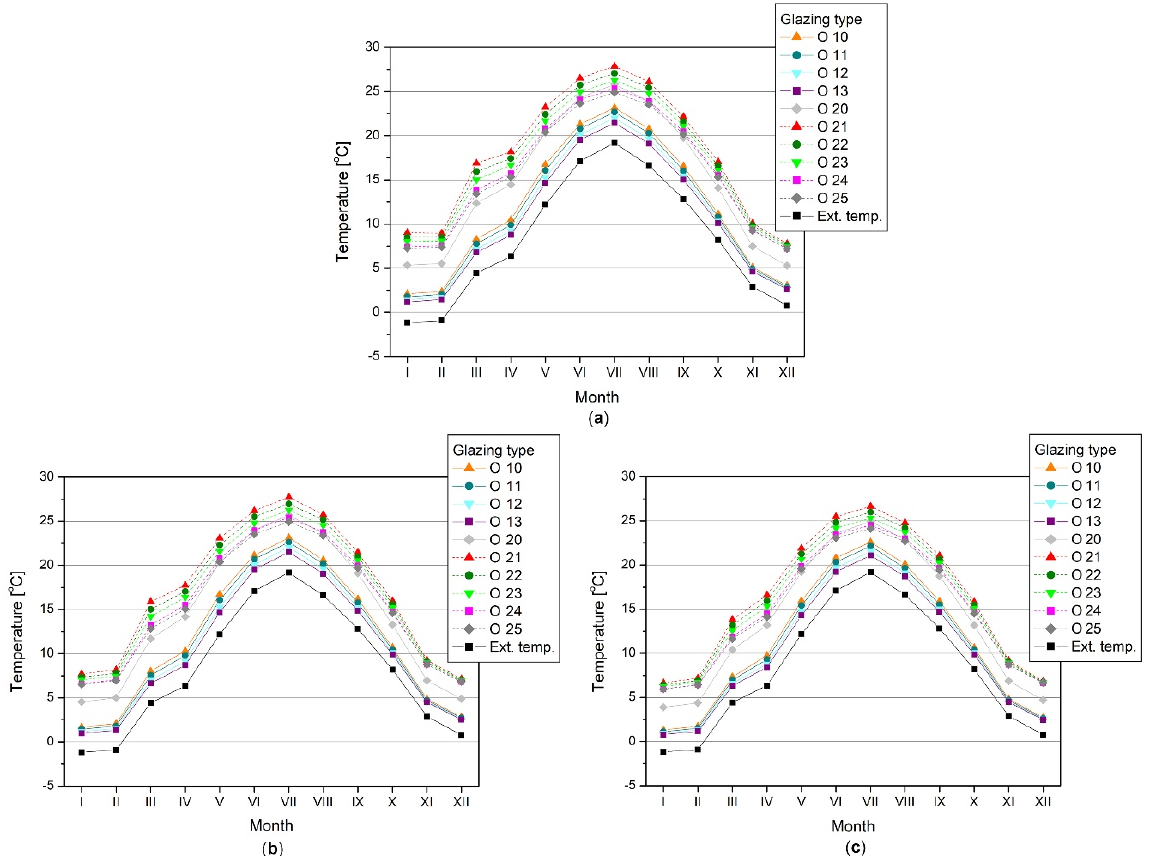
Figure 7. Monthly averaged sunspace temperature (zone 1), glazing height 2.20 m: ( a ) balcony facing south; ( b ) balcony facing east; ( c ) balcony facing west.